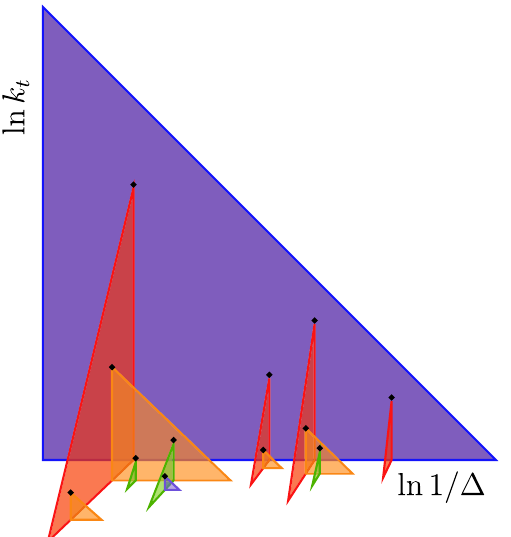
Fig. 1 A graphic representation of the Lund plane for the radiation within a jet. The blue triangle represents the primary Lund plane, with secondary and tertiary Lund planes shown in red and orange, respec- tively